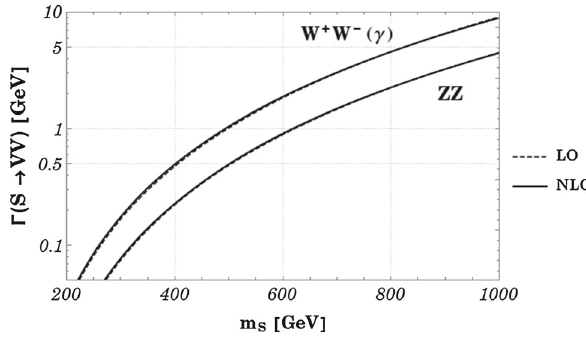
Fig. 7 The same as Fig. 5 but for s α = − 0 .